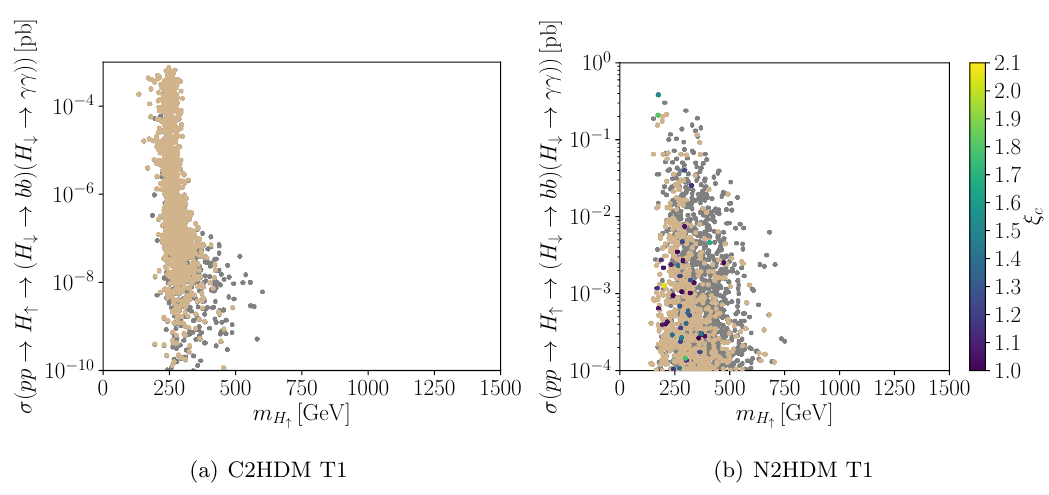
Figure 14 . T1: production rate of H " with subsequent decay into H # H # in the (2 b )(2 (cid:13) ) (cid:12)nal state versus m H for the C2HDM (left) and the N2HDM (right). The color code is the same as " in (cid:12)gure 3. The color bar indicates the strength of the phase transition for (cid:24) c search constraints are